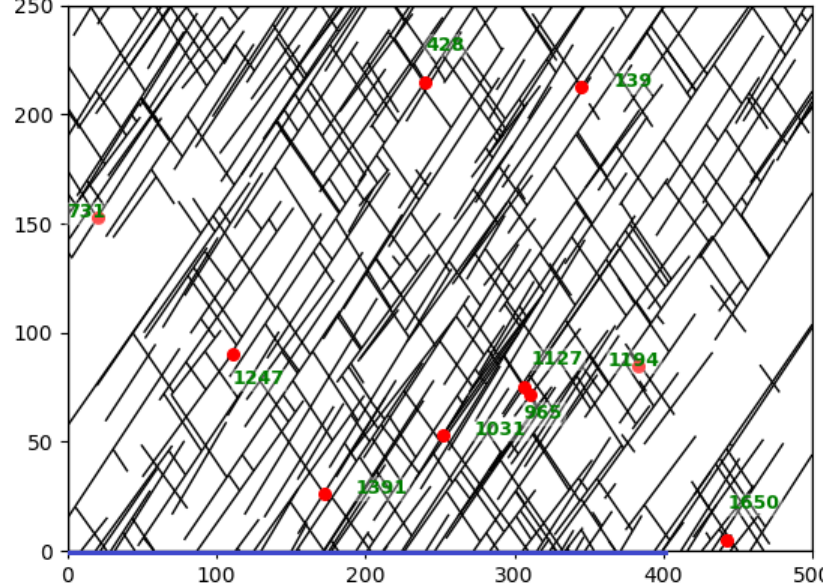
Figure 8—log-log plots of MSD vs. time for 10 sampled nodes in Case 1. Case 2.